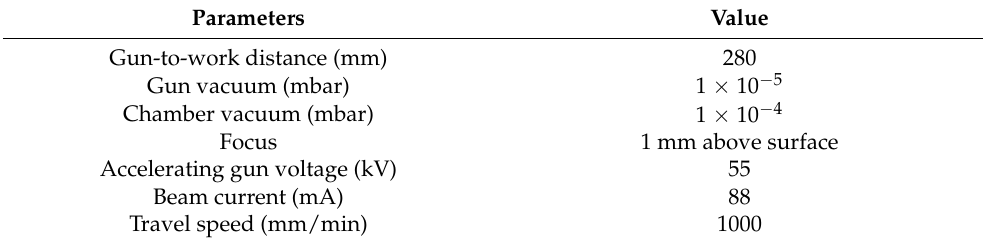
Table 2. Mechanical properties of base materials.